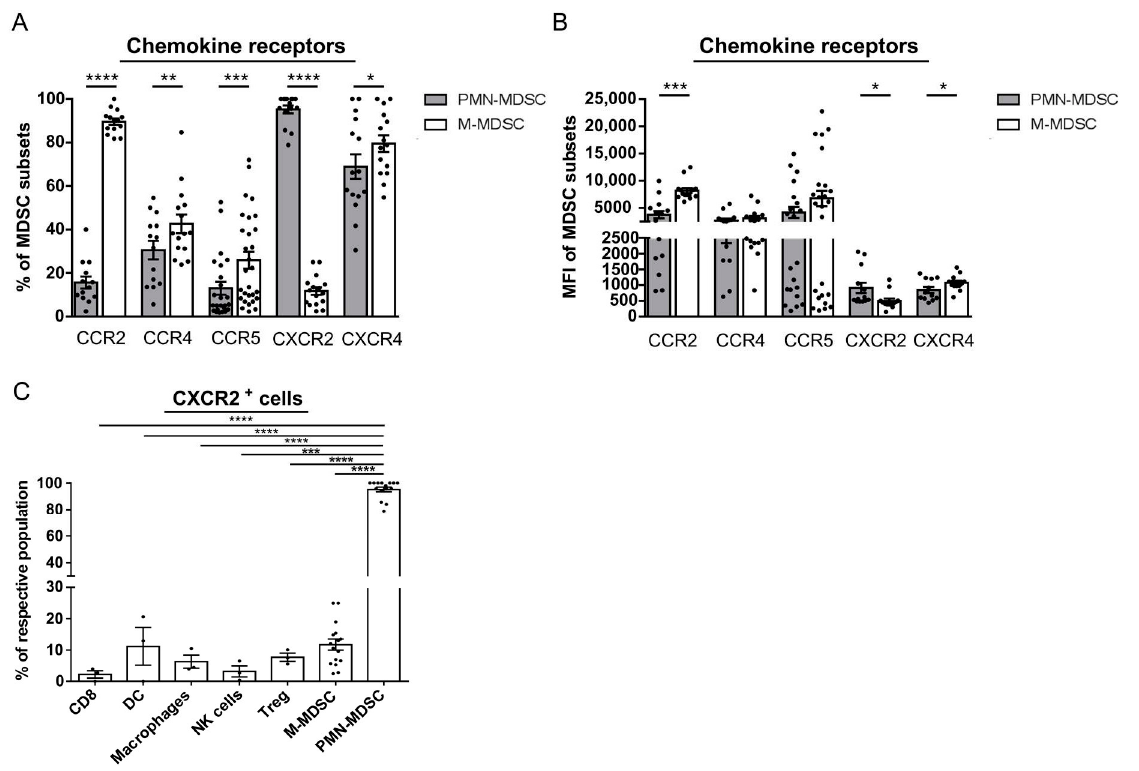
Figure 3. Chemokine receptor expression on melanoma infiltrating immune cells from RET transgenic mice. Expression of CCR2, CCR4, CCR5, CXCR2, and CXCR4 on tumor infiltrating PMN- and M-MDSC from RET transgenic mice was detected by flow cytometry. Data are shown as the percentage cells positive for chemokine receptors among respective MDSC subsets ( A ) or the level of their expression measured as MFI ( B ) (mean ± SEM; n = 12–29 mice/group). ( C ) Expression of CXCR2 on intratumoral CD8 + T cells, CD11c + dendritic cells (DC), F4/80 + macrophages, CD3 − NK1.1 + natural killer (NK) cells, CD4 + FoxP3 + CD25 + regulatory T cells (Treg), M-MDSC and PMN-MDSC was detected by flow cytometry and are presented as the percentage of CXCR2 + cells within or the respective immune cell population (mean ± SEM; n = 3–15 mice/group). * p < 0.05, ** p < 0.01, *** p < 0.001, **** p < 0.0001.